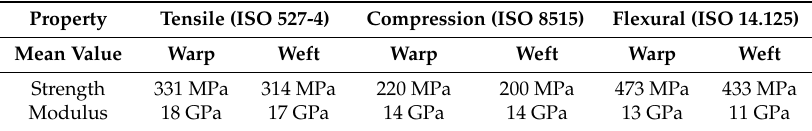
Table 2. Mechanical properties of GFRP laminates (supplied by the manufacturer).